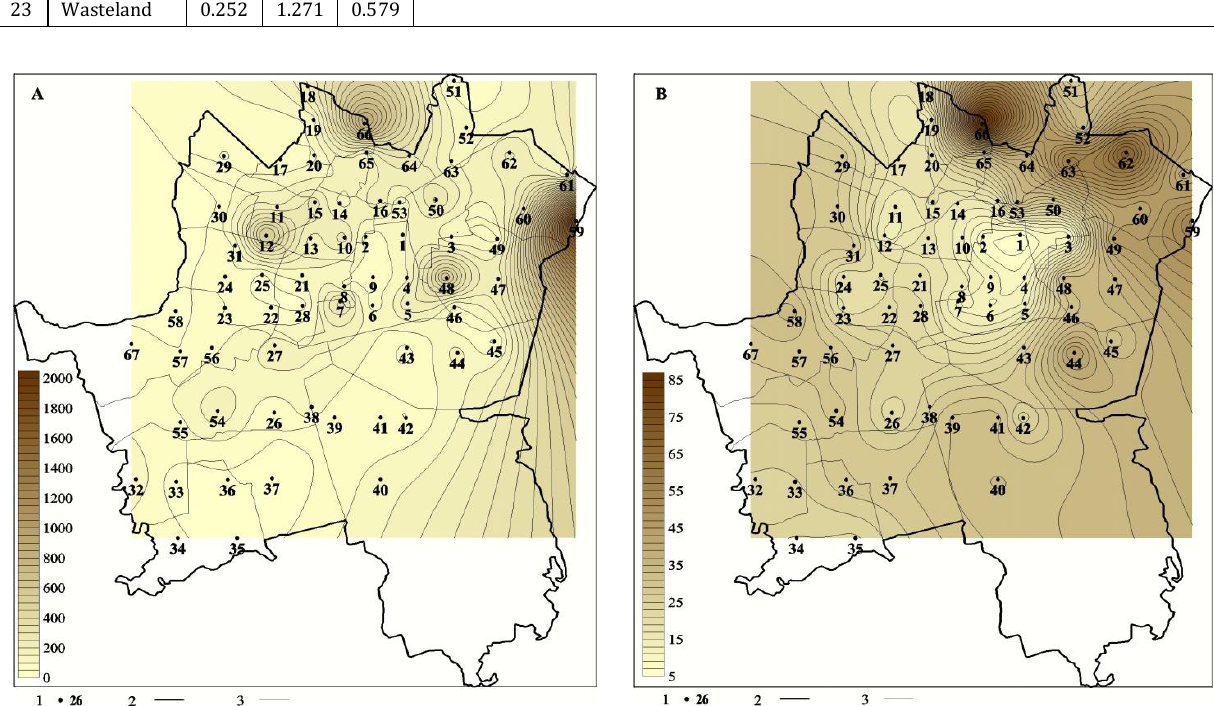
Fig. 2 A, B. Distribution of lead: A. in soil [mg kg -1 ] and B. in T. officinale Web. leaves [µg g -1 ] within the city of Katowice 1 – collection points; 2 – the city boundaries; 3 – boundaries of